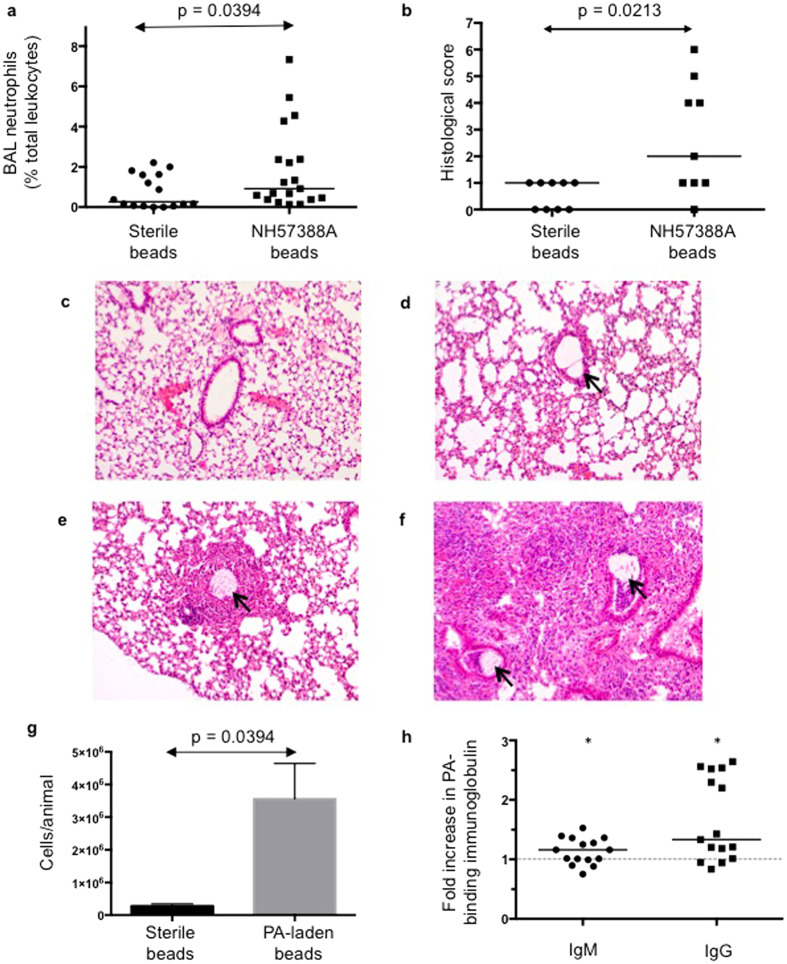
Neutrophilic inflammation, histological changes and Pseudomonas-binding immunoglobulin in mice two-weeks following NH57388A-laden agar bead inoculation.C57BL/6 mice received sterile or NH57388A-laden agar beads. (a) Two-weeks post-instillation, bronchoalveolar lavage (BAL) leukocytes were strained for Gr-1 followed by flow cytometry. BAL neutrophils (percent of total leukocytes) in animals treated with sterile beads (N = 16) were compared mice inoculated with NH57388A-laden agar beads (N = 19) at 2-weeks. Line indicates median. P-value related to Mann-Whitney test. (b) Quantitative histological scores of animals treated with sterile agar beads (N = 9) or NH57388A (NH)-laden beads (N = 9). Line denotes median score. P-value related to Mann-Whitney test. (c–f) H&E staining of representative lung sections (all at x10 magnification) in C57BL/6 mice with no treatment (healthy control) (c), 2-weeks post-inoculation with sterile agar beads (d), 2-weeks post-inoculation with NH57388A-laden agar beads (e), or with overwhelming acute infection post-inoculation with PA-laden agar beads. Black arrows highlight intra-bronchial agar beads. (g) Mediastinal lymph node cell counts in mice treated with sterile and PA-laden agar beads two-weeks following bead instillation. Columns shown mean + SD. P-value relates to comparison by t-test and includes results from 3 experiments (each with N = 9–10 mice/group). (h) Serum PA-binding immunoglobulin M (IgM) and G (IgG) levels showing fold increase in IgM and IgG levels in NH57388A treated animals compared with sterile bead treated controls two-weeks post-instillation. Line represents median. *Denotes p < 0.05 compared with theoretical median of 1.0 via Wilcoxon Signed rank test. Combined results from two separate experiments.